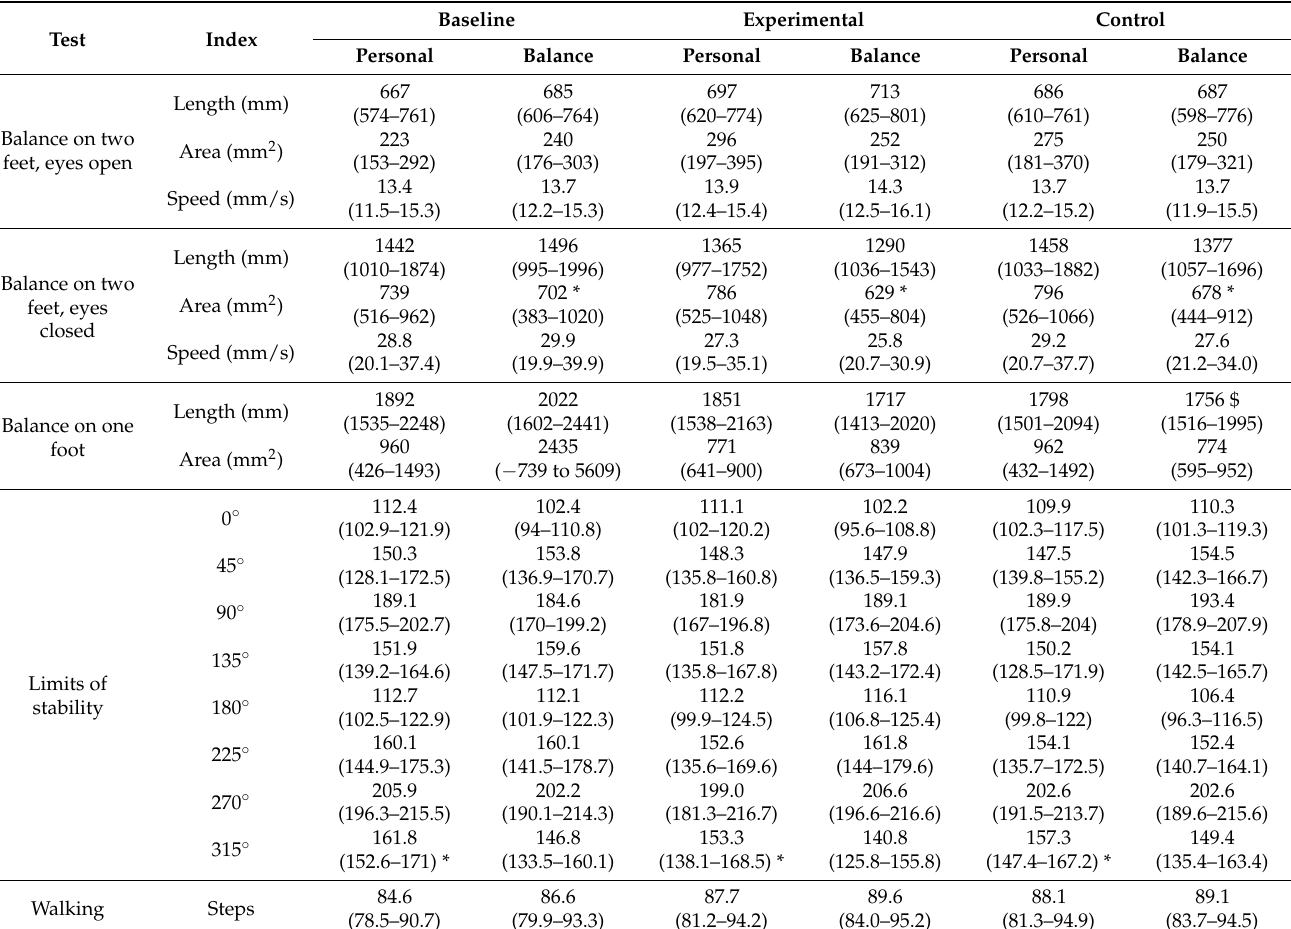
Table 3. Obtained data during different test sessions while wearing balance or personal shoes.